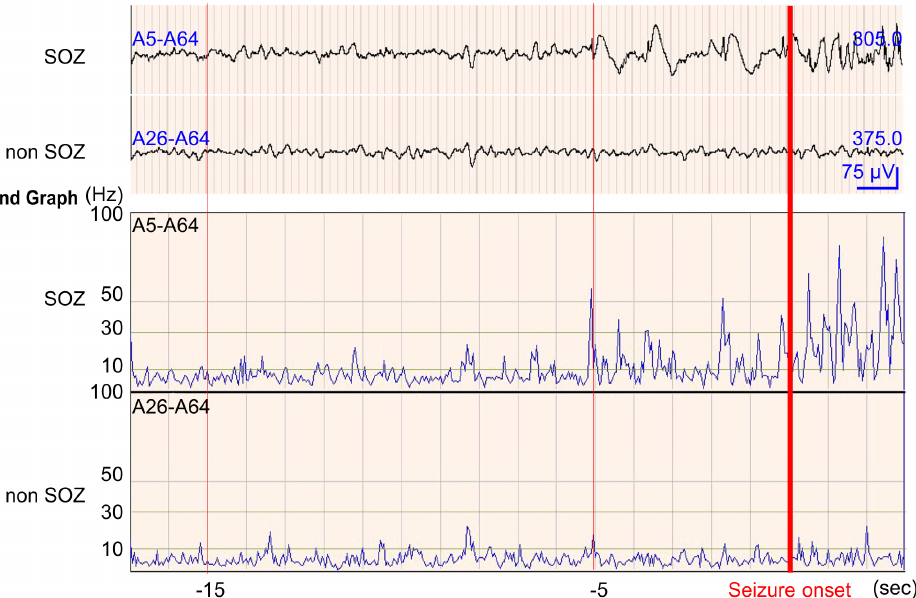
Fig 3. CDM band analysis associated with seizure onset on ECoG. Values for all x-axes are given in seconds. Values for all y-axes are given in Hz. The upper row showed ECoG at SOZ and non-SOZ electrodes, with the ECoG shown 20 s before and after seizure onset by visual inspection. The lower rows showed the CDM band graph between 0 and 100 Hz. Oscillations between 10 and 30 Hz were detected at SOZ from 15 s before seizure onset. Oscillations higher than 30 Hz were detected at SOZ from 5 s before seizure onset.